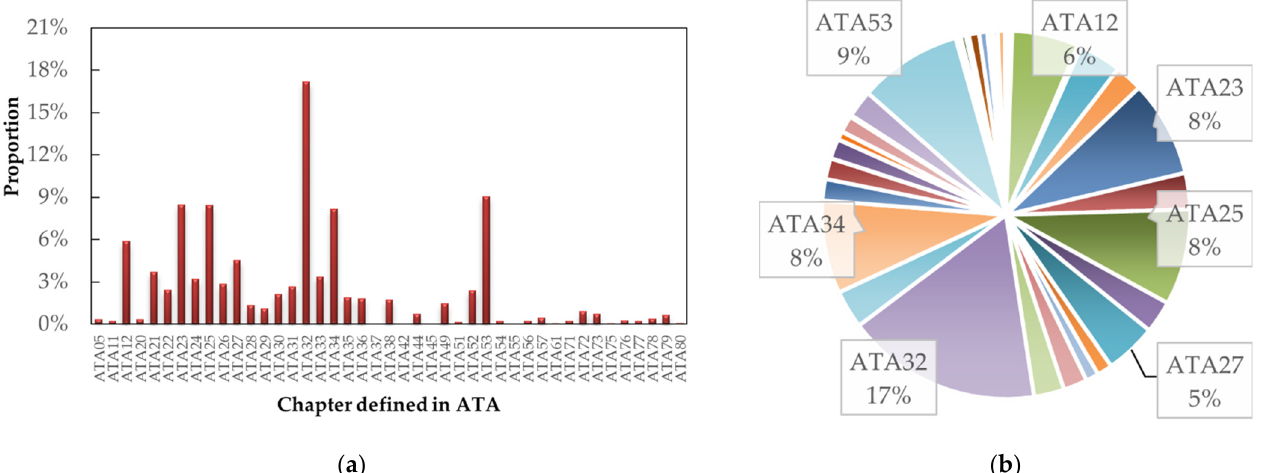
Figure 3. Proportion of fault maintenance records in typical systems. (ATA: Air transport association). ( a ) Histogram of percentages; ( b ) Pie chart of percentages.